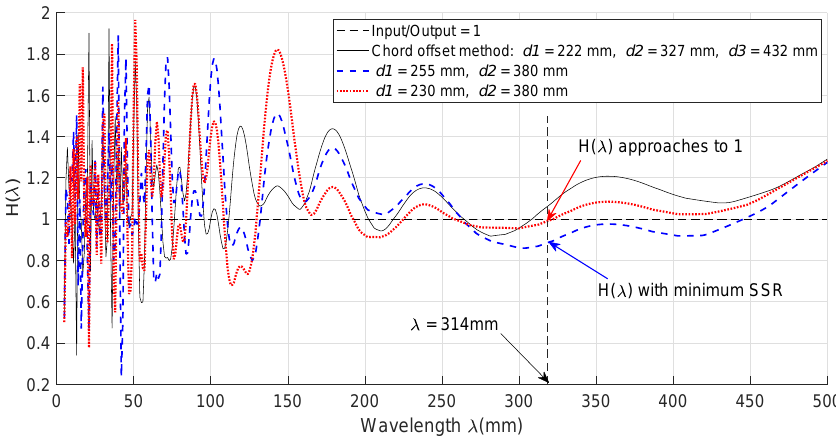
Figure 6. Minimized residual results with two sensors focused on a periodic wavelength in the chord offset synchronization method.